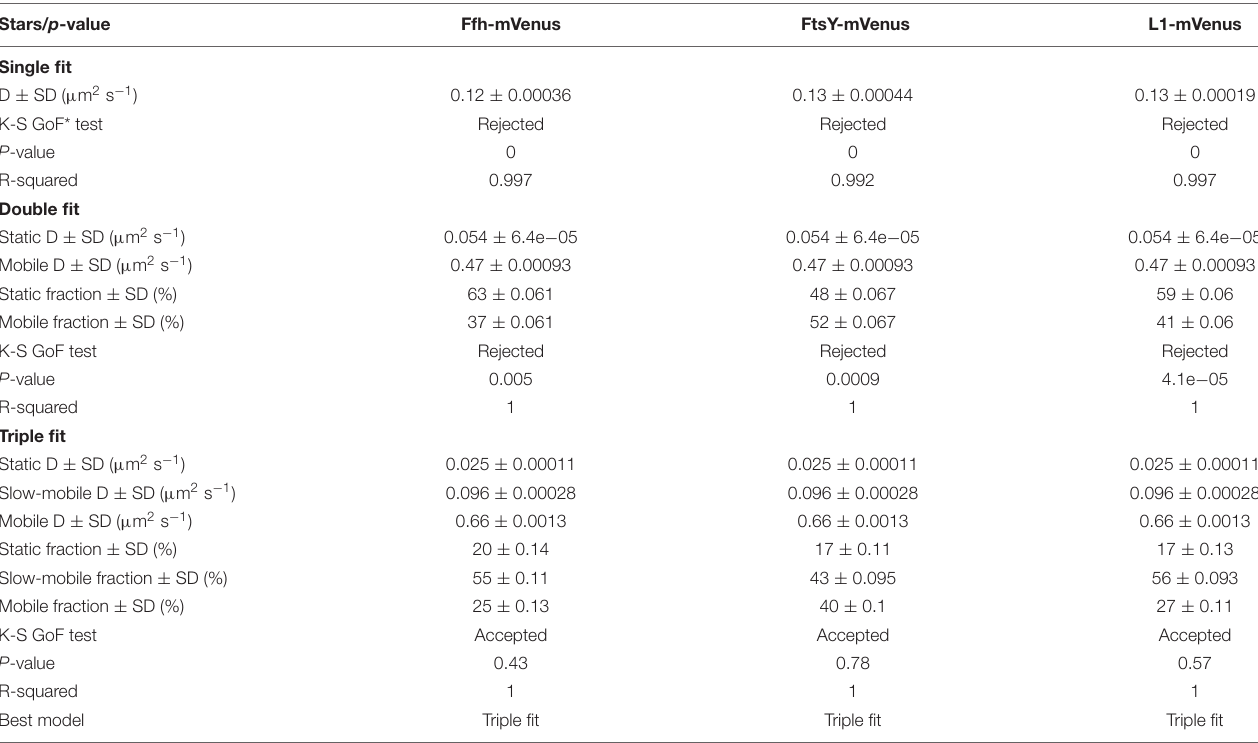
TABLE 2 | Gaussian mixture modeling analyses. Stars/ p